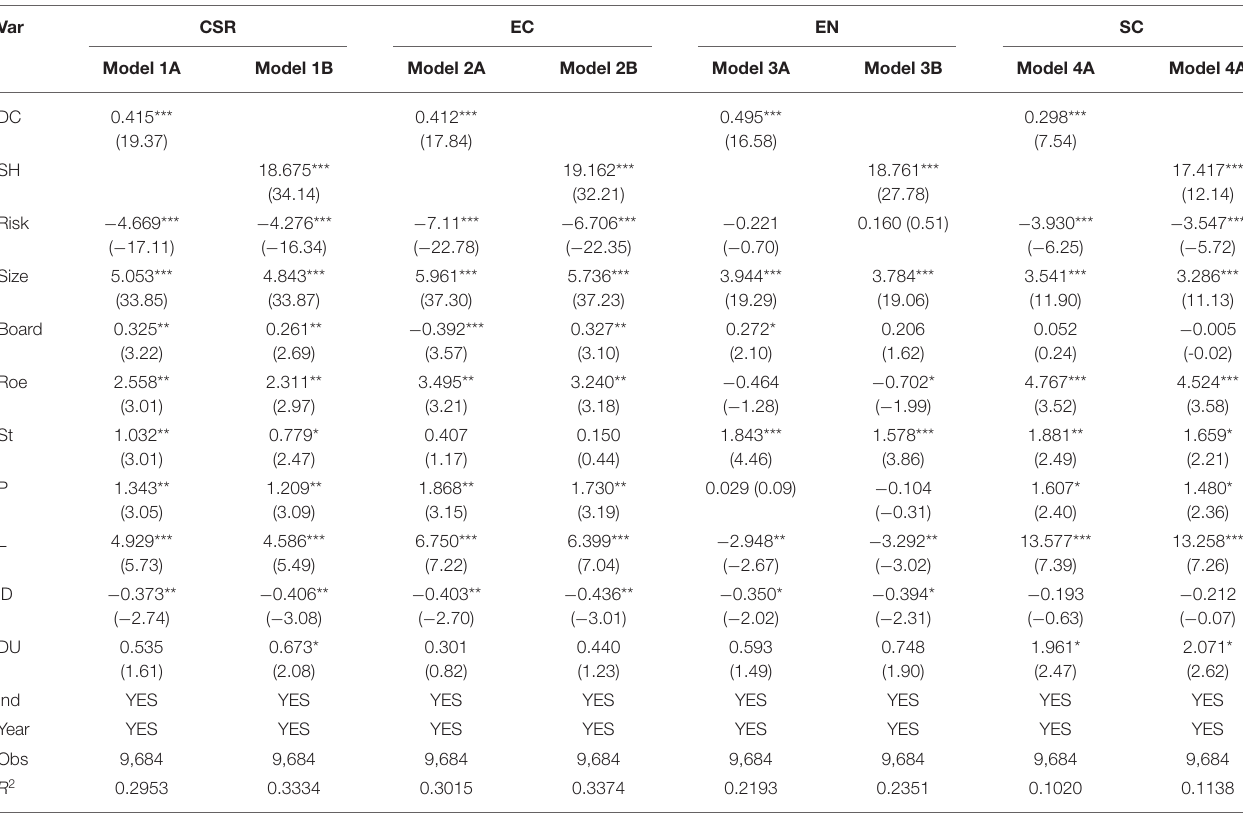
TABLE 3 | Results of regression analysis for interlocking directorate network position and CSR.